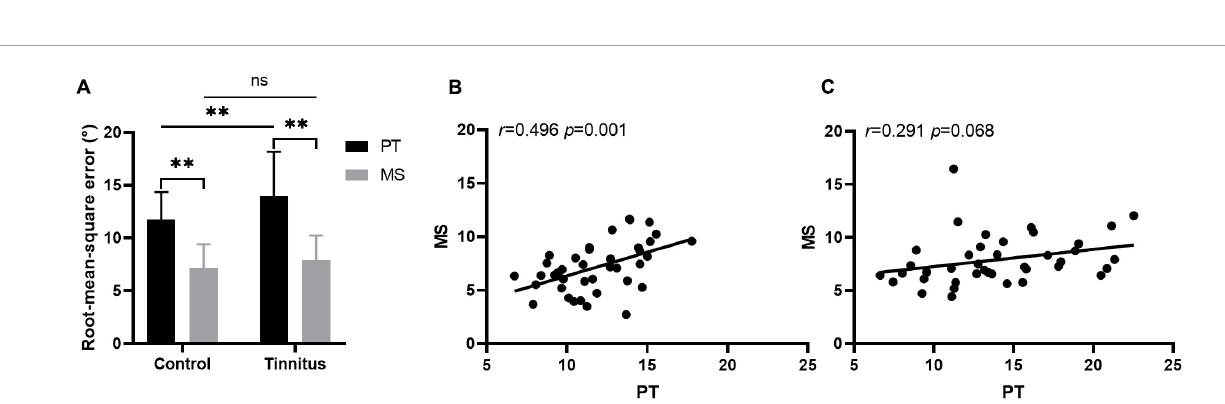
FIGURE4 Sound localization behavior. (A) The accuracy of sound source discrimination of the participants under different stimulus conditions. PT, pure tone; MS, monosyllable. ∗∗ P < 0.01, ns, not significant. The correlation between the RMSE scores of the PT and MS conditions in the control (B) and tinnitus (C) group.